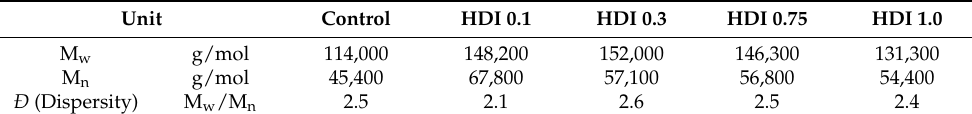
Table 2. Polymer molecular weight and dispersity (M w /M n ) of PLA/PBSeT blends.